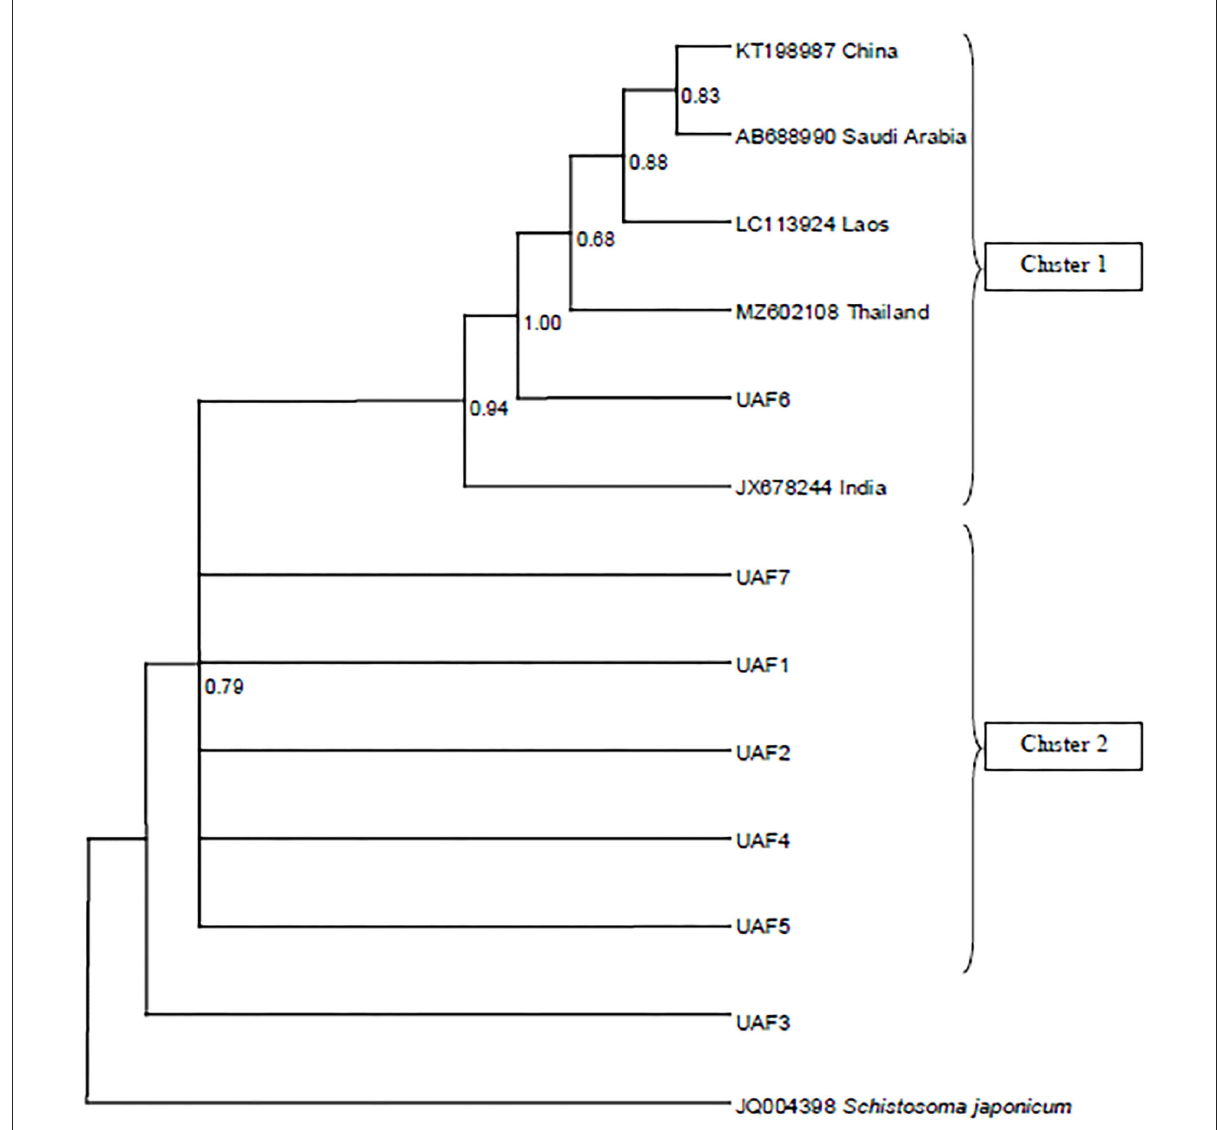
FIGURE1 Bayesian phylogeny of Pakistani Paramphistomum epiclitum isolates inferred from the cox 1 gene. Schistosoma japonicum is used as outgroup. Posterior probability values are depicted at the